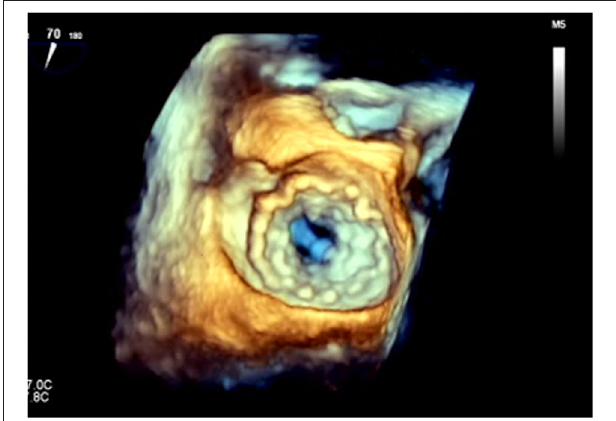
FIGURE 4 | 3D transesophageal echocardiography showing the atrial side of a Tendyne TM valve (Abbott) after deployment. It exhibits the huge artificial anchoring surface of these